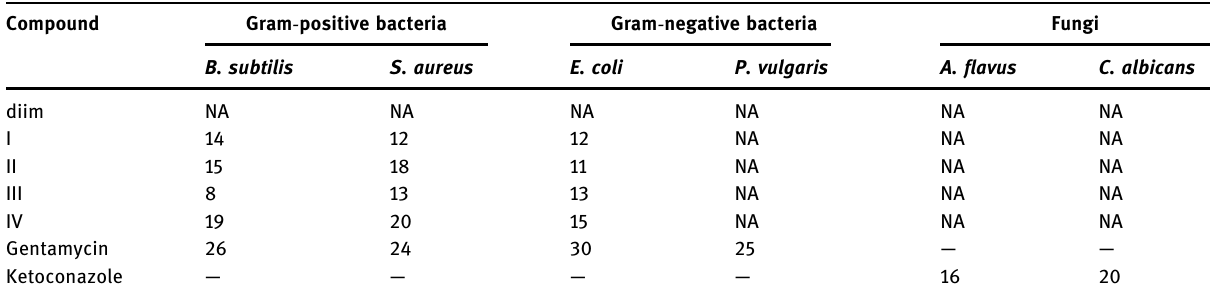
Table 6: Biological evaluations for methoxy - diim ligand and its metal complexes ( concentration: 10 mg/mL )